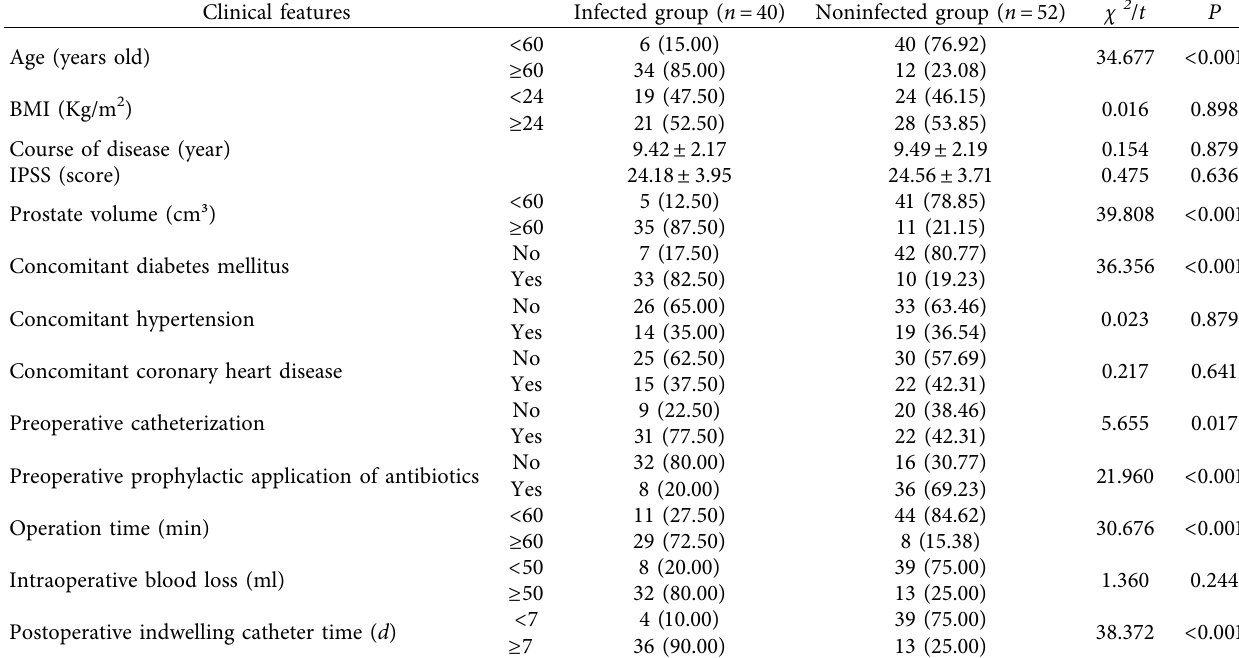
Table 1: Univariate analysis of postoperative urinary pathogenic bacteria infection in patients with BPH.